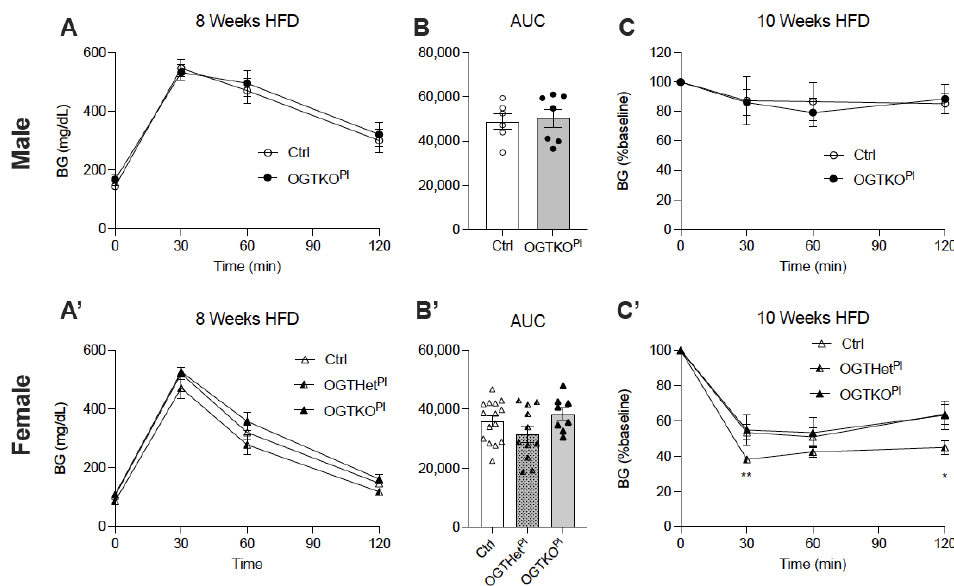
Figure 4. Heterozygote placental OGT female mice demonstrated increased insulin tolerance. ( A ) IPGTT and ( B ) calculated AUC at 8 weeks of HFD for male (n = 6, 7) and ( A’ , B’ ) female mice (n = 8, 15). ( C ) ITT at 10 weeks on HFD for male (n = 4, 5) and ( C’ ) females (n = 7, 15). Blood glucose values post insulin injection are expressed as a percent of baseline blood glucose. ( A , C ) were presented as mean ± SEM, two-way ANOVA. ( B ) was presented as mean ± SEM, unpaired t -test for males and one-way ANOVA for females. p values, * p < 0.05, ** p < 0.01.